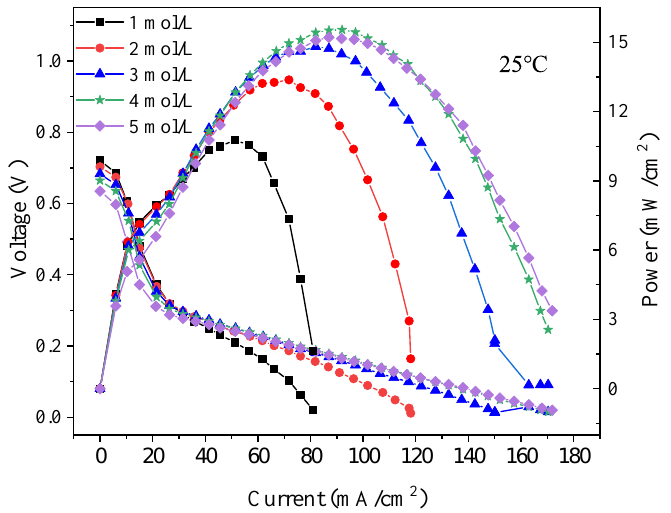
Figure 11. Polarization curves of foamed stainless steel µ DMFC at 1 mol/L–5 mol/L methanol solution